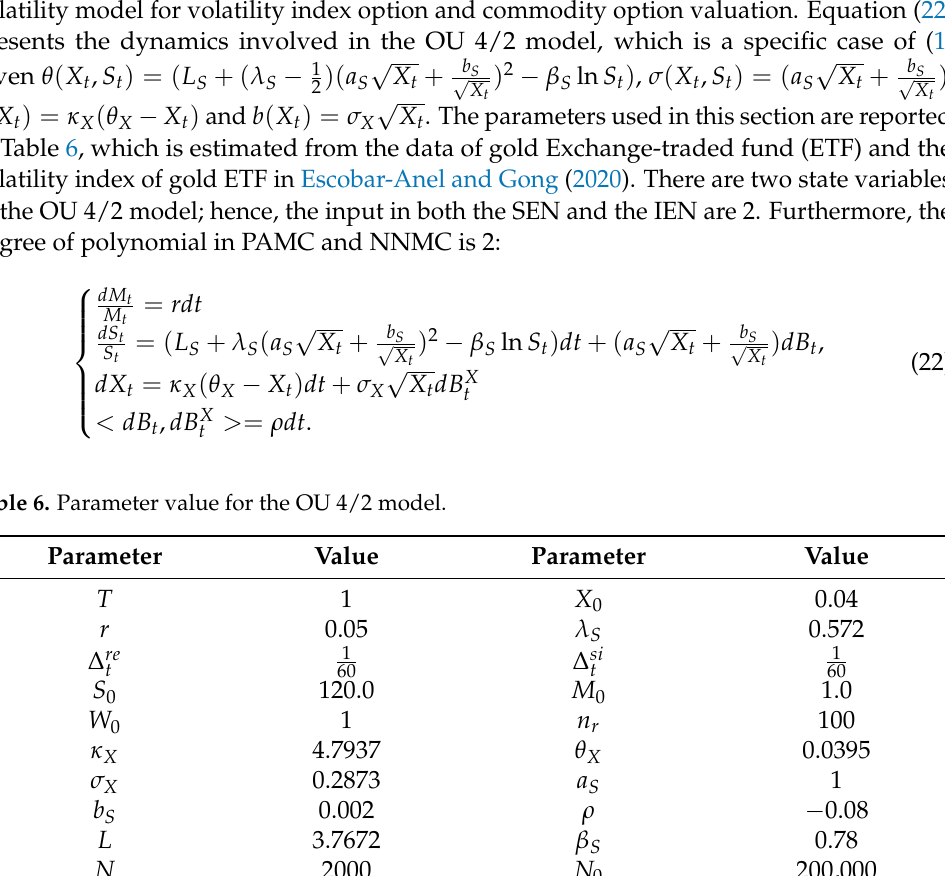
Figure 5. S t follows the 4/2 model with a market price of risk λ S ( a expected utilities obtained with theoretical results and approximation methods versus investment horizon T ; and ( b ) shows the CERs versus investment horizon T given γ = 2.